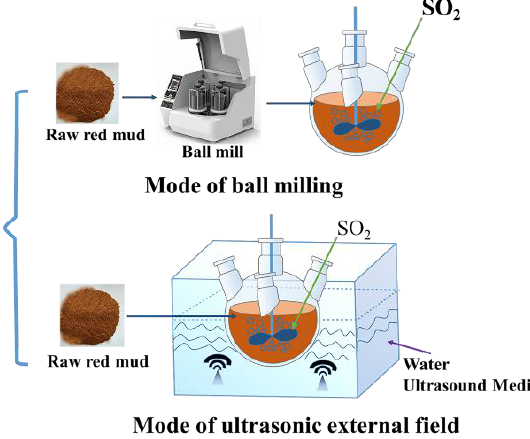
Figure 2. The two modes of action of the external